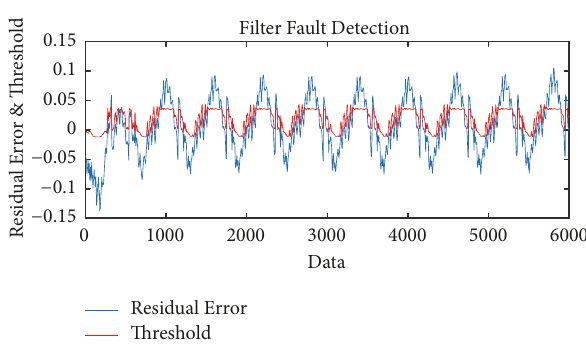
Figure 9: Detection result for filter fault.